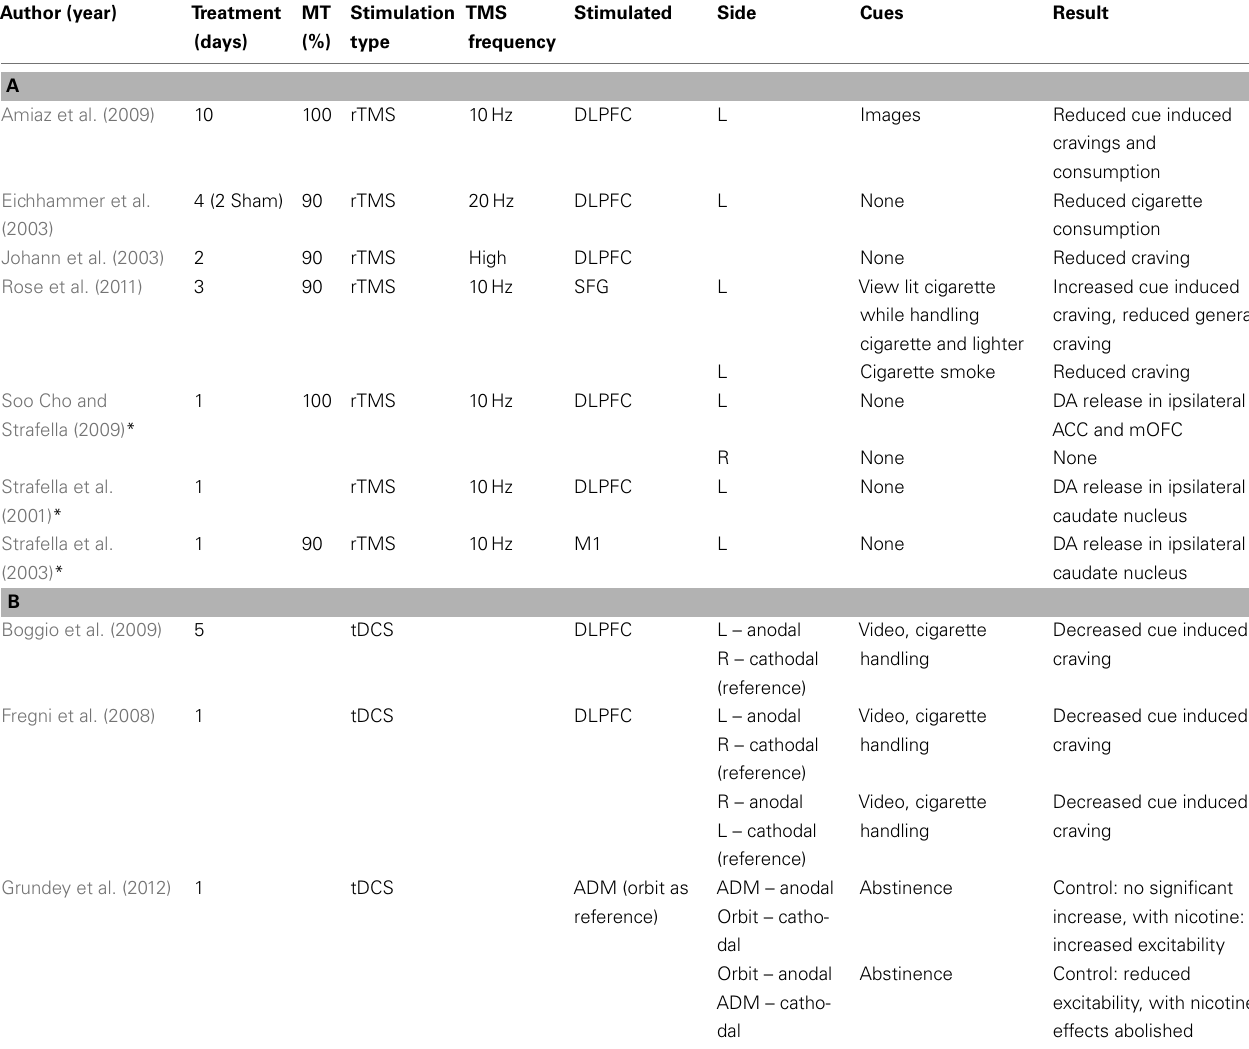
Table 2 | Non-invasive brain stimulation, smoking, and reward – studies reporting the effects of rTMS and tDCS on smoking, related craving, and dopaminergic